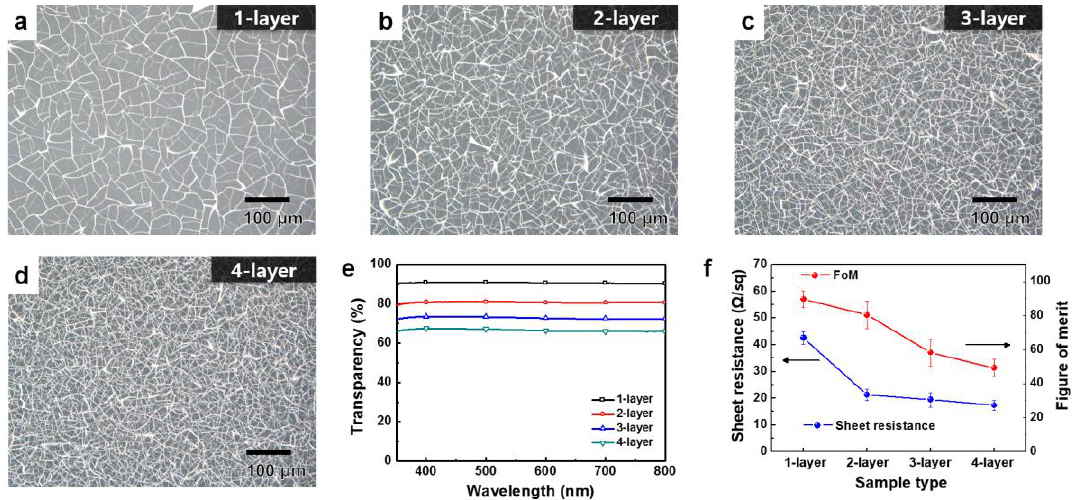
Figure 3. OM images of the multi-layered MMSs; ( a ) single-; ( b ) double-; ( c ) triple-; and ( d ) quadruple-layer; ( e ) optical transparency in the visible region; and ( f ) sheet resistance and calculated FoM of the fabricated multi-layered MMSs.